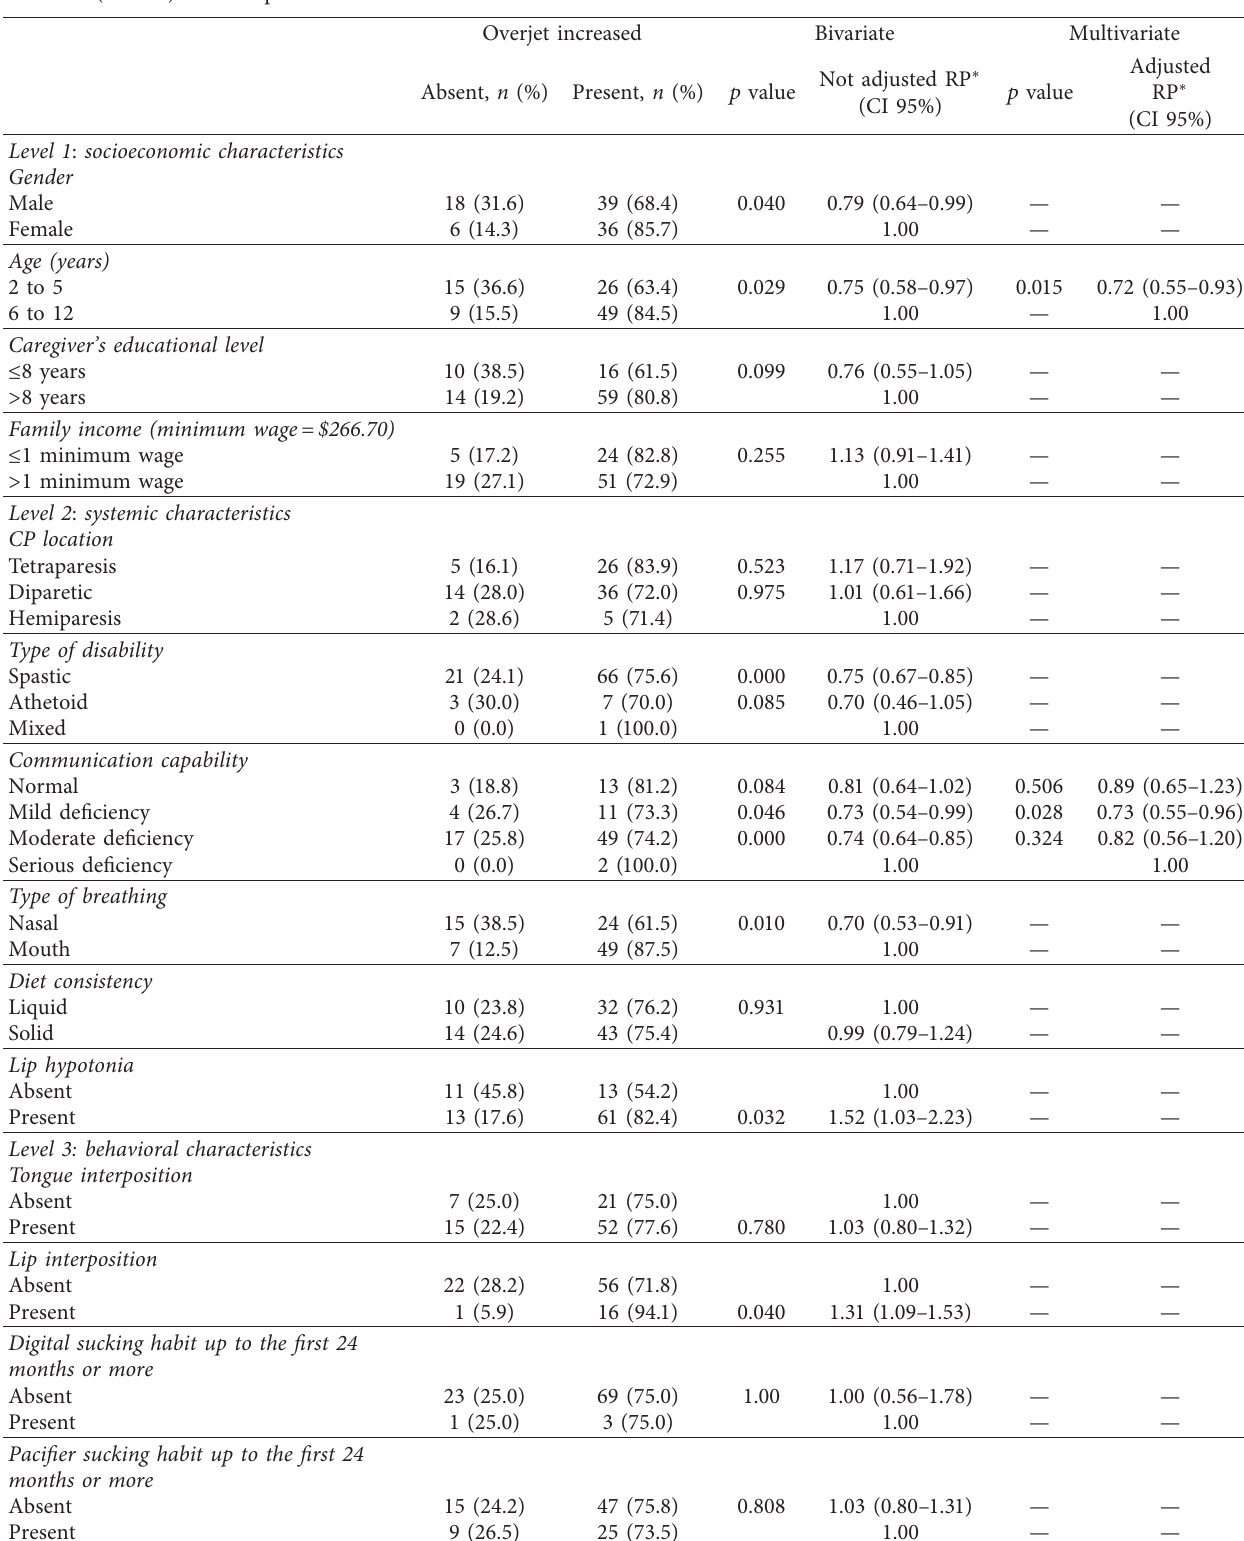
Table 2: Distribution of children of 2–12 years with CP in bivariate and multivariate Poisson regression models for the presence of overjet increased ( > 2 mm) and independent